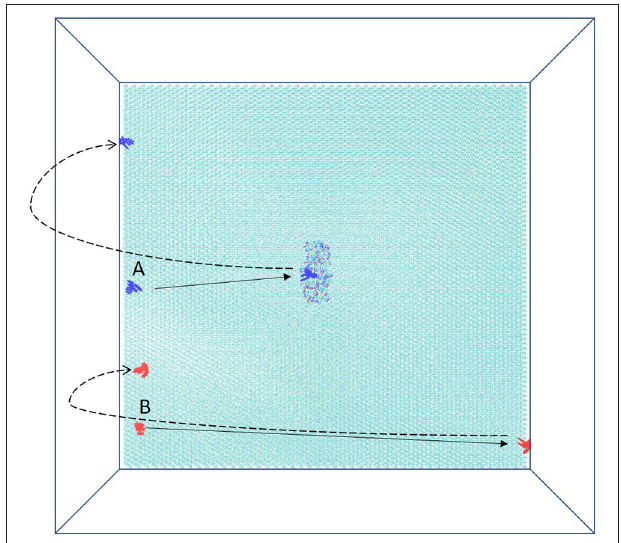
FIGURE 3 | Schematic top view of the simulation box. HIVp is placed on CH 3 -SAM, and two initial starting positions of xk263, A and B, are on the yz-plane. The simulation is terminated after xk263 binding to HIVp, and another new replica will start. If xk263 reaches the simulation is also terminated, and a new replica will start in a different position on the yz-plane.